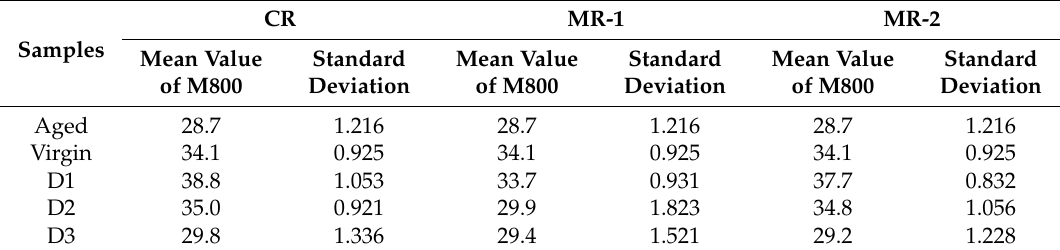
Table 5. Mean values of M800 and their standard deviations of GPC